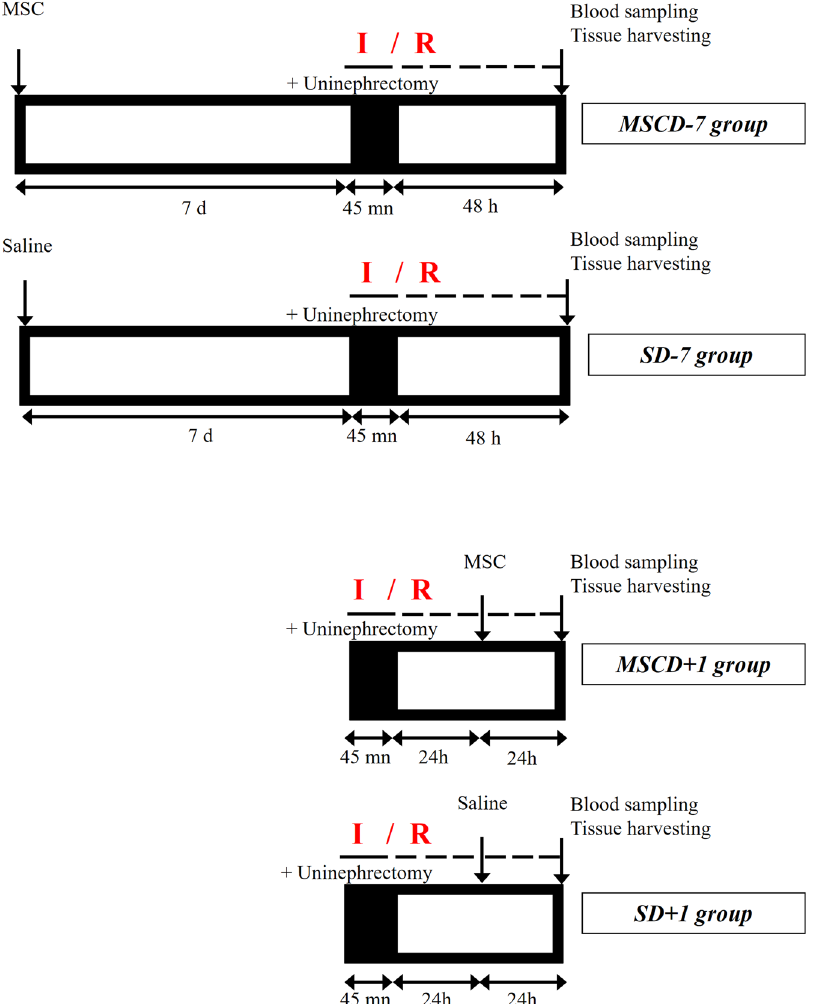
Figure 5. Renal ischemia/reperfusion model. Male Lewis rats aged of 8–10 weeks were divided in 4 groups. MSCD − 7 group and MSCD + 1 group received i.v. (tail vein) injection of MSC (1.5 × 10 6 in 1 ml saline) 7 days before or 1 day after renal ischemia/reperfusion (I/R), respectively. Control groups SD − 7 and SD + 1 received equal volume of saline at similar time-points. Left renal ischemia by clamping the renal pedicle lasted 45 minutes. Right nephrectomy was simultaneously performed. Blood sample and left kidney were collected at 48 h post